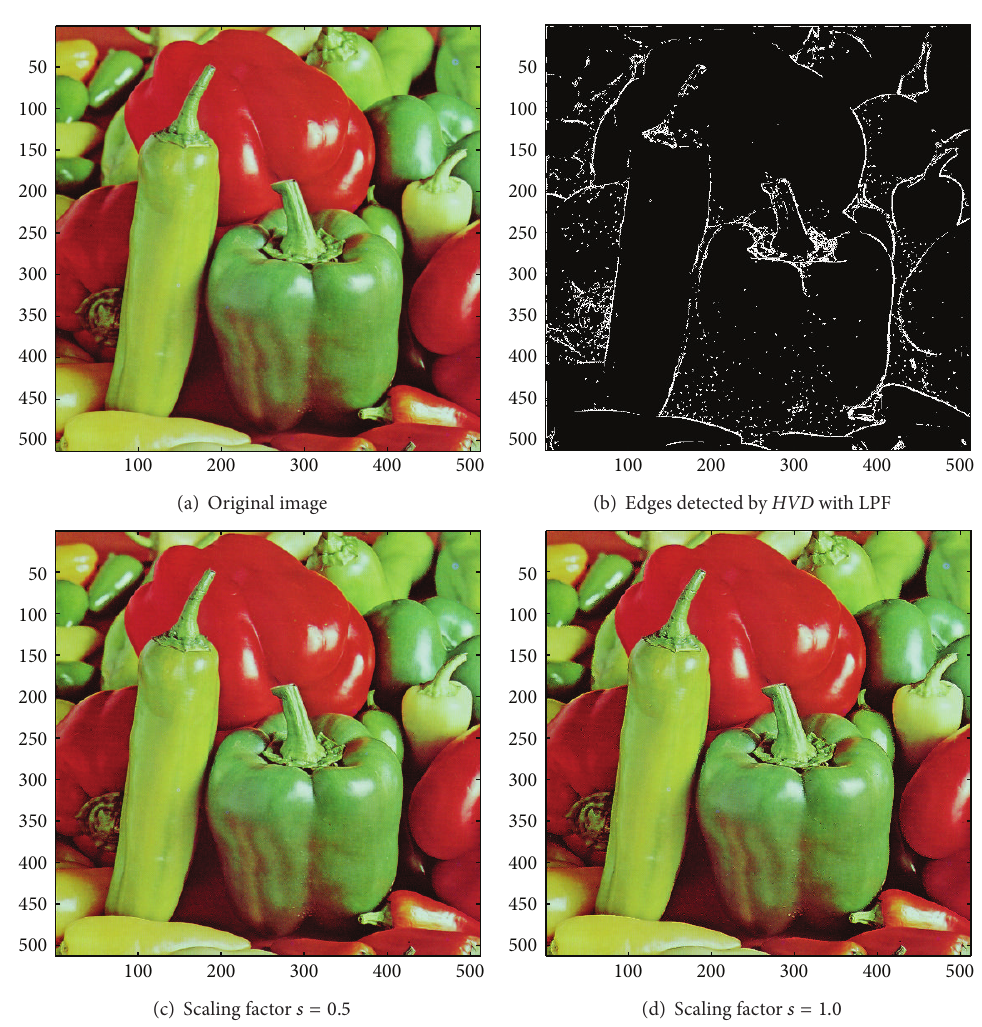
= 22 for HVD . (a) The image “Peppers” (512 × 512 color image). (b) Edges detected by HVD with LPF. (c and d) Sharpened Figure 7: 𝜃 eth results by HVD with scaling factors 0.5 and 1.0 ,